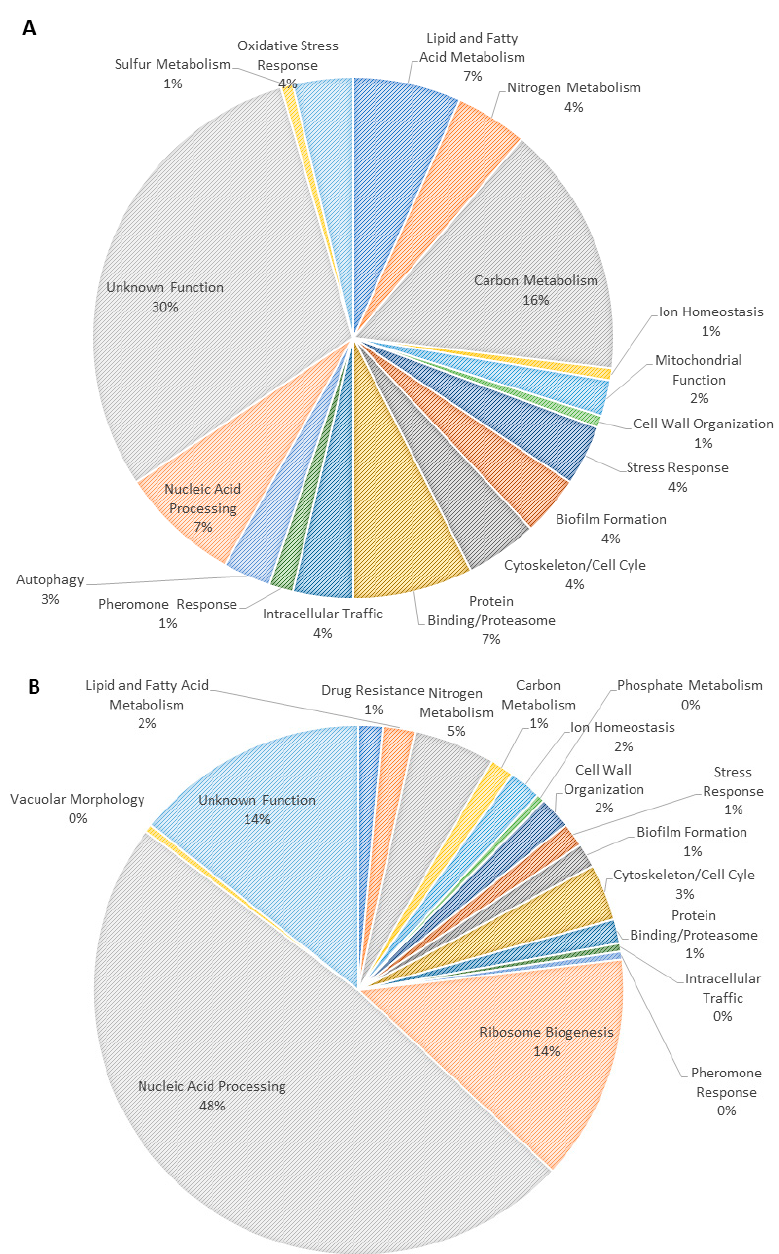
Figure 2. CgMar1-regulated functional groups. Differentially expressed genes in exponential-phase KUE100_ Δ cgmar1 cells compared with KUE100 wild-type cells after 1 h of fluconazole exposure. ( A ) Positively CgMar1-regulated genes (downregulated in the mutant strain). ( B ) Negatively CgMar1- regulated genes (upregulated in the mutant strain).